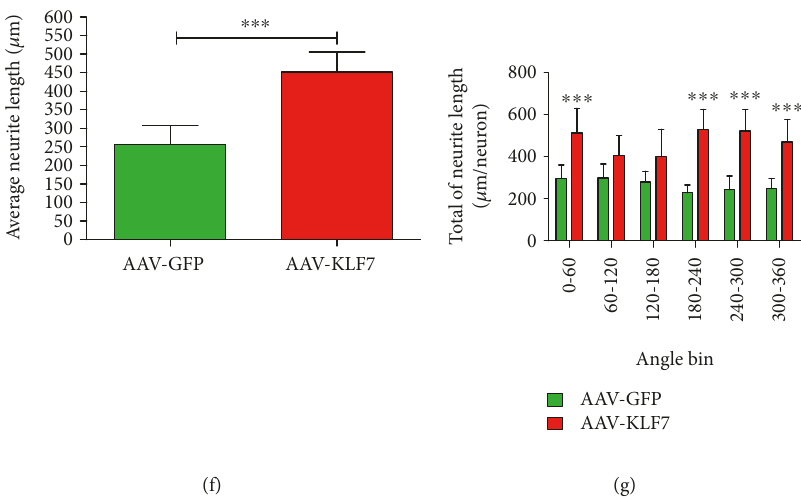
Figure 4: AAV-KLF7 promotes neurites outgrowth in vitro . Time-lapse imaging of spinal cord neuron axonal outgrowth in AAV-GFP (a) and AAV-KLF7 (b) groups on 0, 3, and 4 days (IncuCyte ZOOM Kinetic Imaging System) in vitro . Data represent neurite length/neuron (c) and neurite branch points/neuron (d) ( n = 50 neurons/group). (e) Representative immunostaining of DRG explants in each group; neurite outgrowth was labeled with β -III-tubulin (green). A comparison of the average length (f) and total of neurite length per neuron within di ff erent angle bins (g) by Sholl analysis ( n = 6 /group). Error bars denote SD. ∗∗∗ P < 0 001 versus the AAV-GFP control group. Student ’ s t -tests. Scale bars: 50 μ m or 100 μ